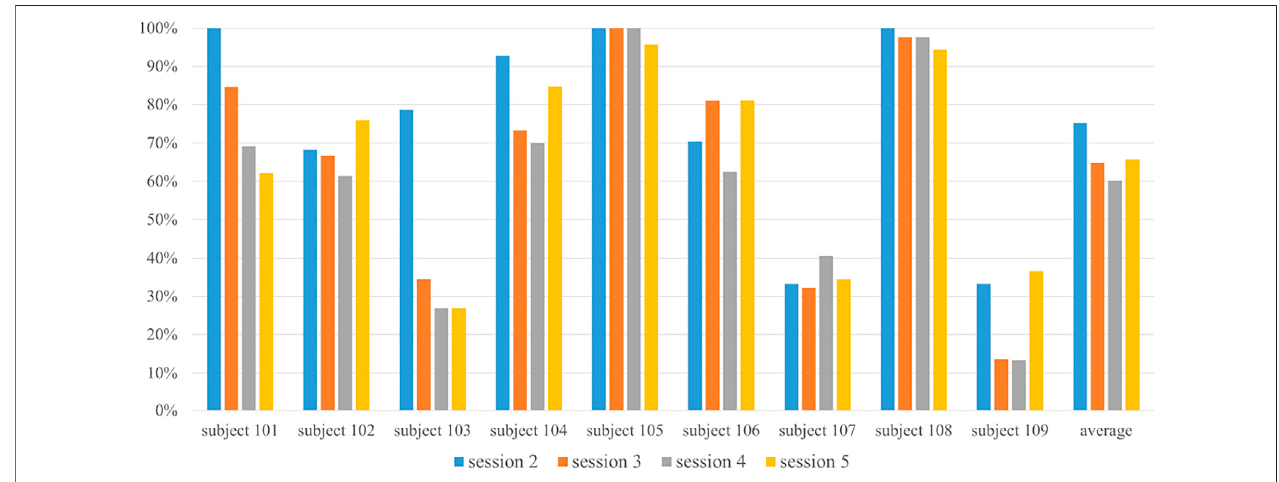
FIGURE 11 | Normalized turn-taking behavior result for all subjects during intervention